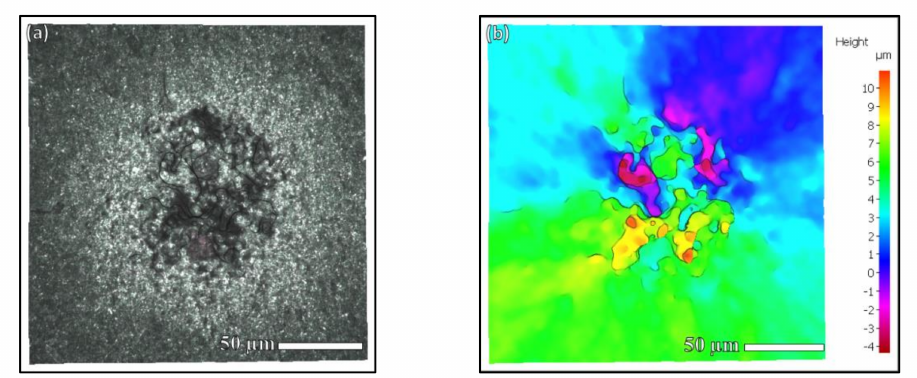
Figure 10. 3D morphology scanning of RA: ( a ) scanning area of RA; ( b ) 3D contour of RA. There are several platforms with different heights in the RA resulting in large